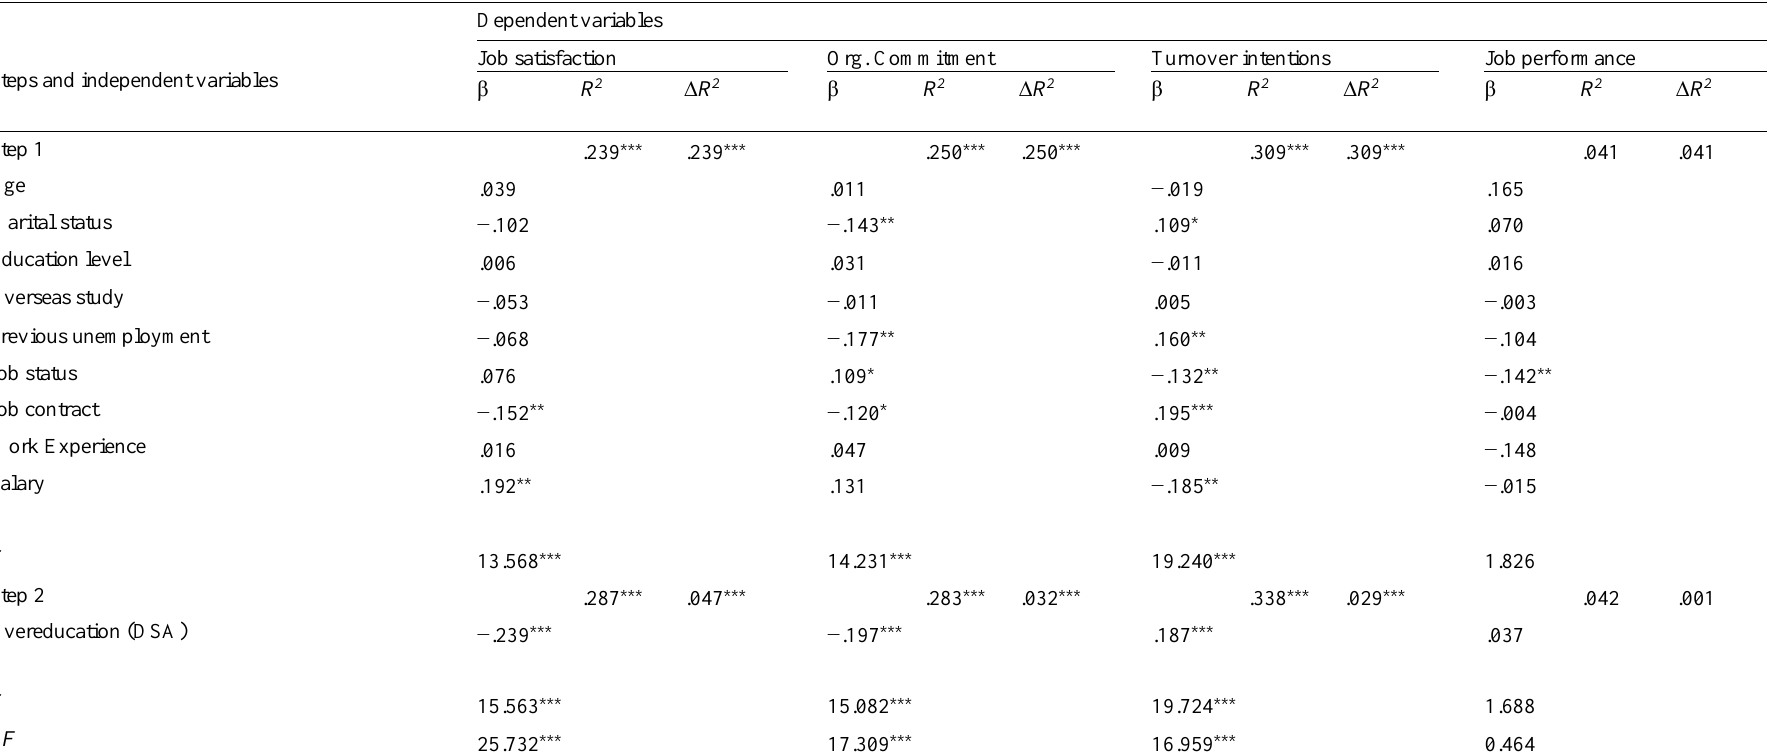
Table 2: Hierarchical multiple regression analyses summary for overeducation (DSA) predicting job outcomes and